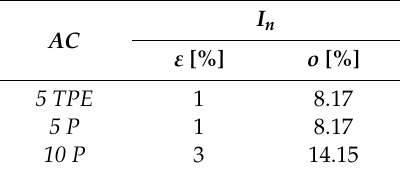
Table 4. Results for protective purpose